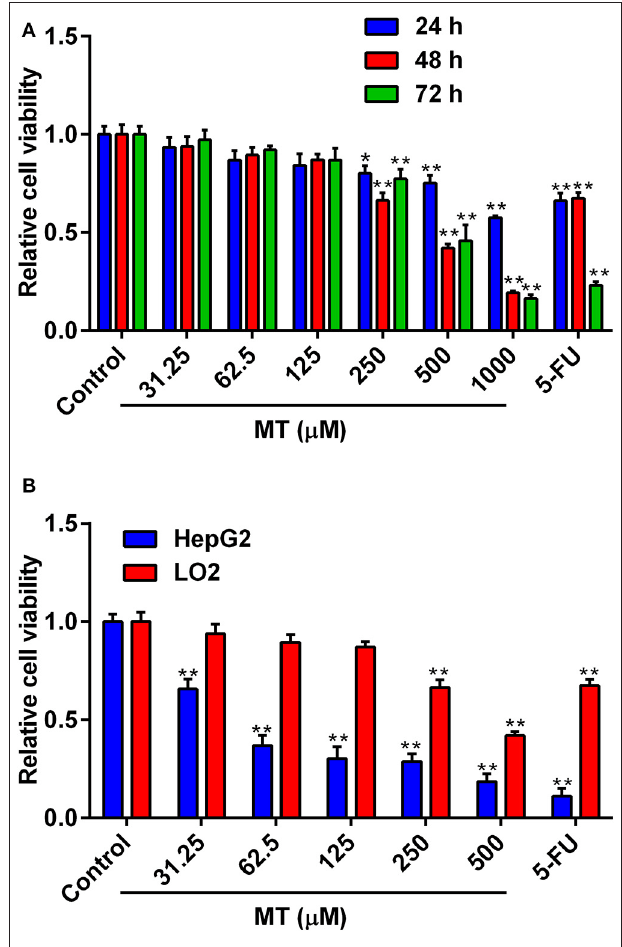
FIGURE 1 | Anti-proliferative activity of MT on LO2 and HepG2 cells. (A) Effects of MT and 5-FU on the proliferation of LO2 cells were determined by MTT assay. (B) Effects of MT and 5-FU on the proliferation of HepG2 cells and LO2 cells at after 48h treatment with MT were determined by MTT assay. Data from at least three independent experiments performed in triplicates are presented; * P < 0.05 and ** P < 0.01 compared to the corresponding